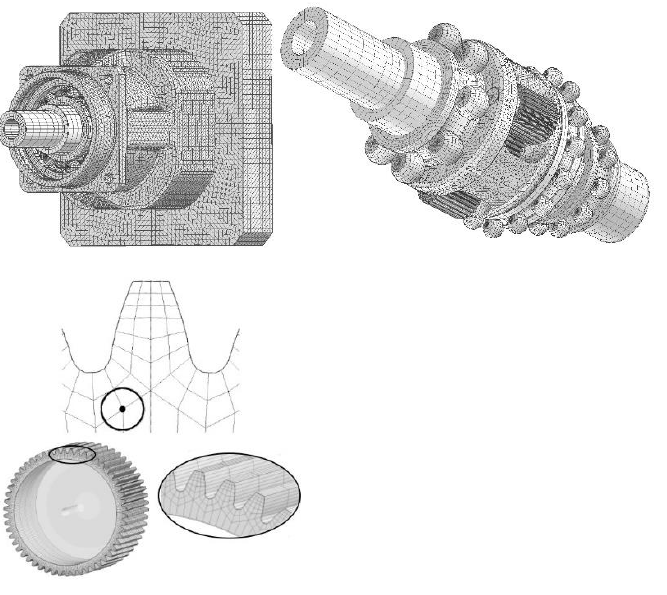
Figure 4. FE model of the gearbox.